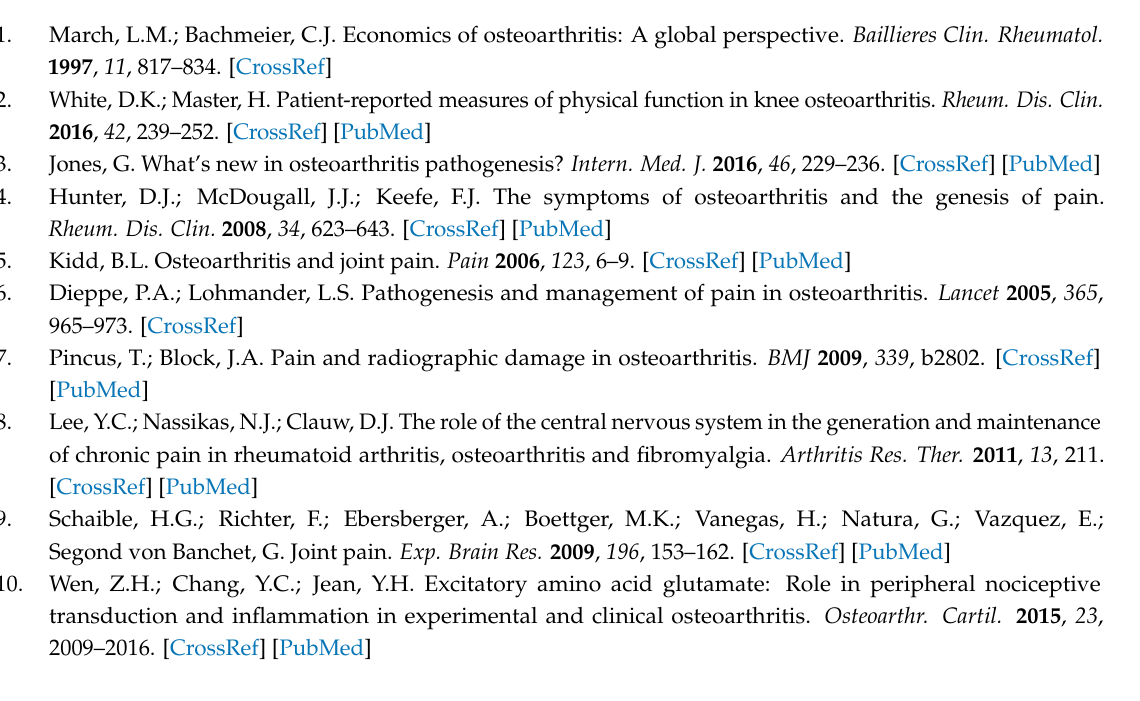
Table S1: Characteristic of 18 genes enriched in Gene Ontologies (GO) in the category of biological process. Author Contributions: A.B.-N. and H.S. conceived the project; A.B.-N. designed the experiments; S.F.F. provided patients’ material; A.B.-N. and S.A. performed the experiments; F.C.-G. analysed the data; A.B.-N., F.C.-G.